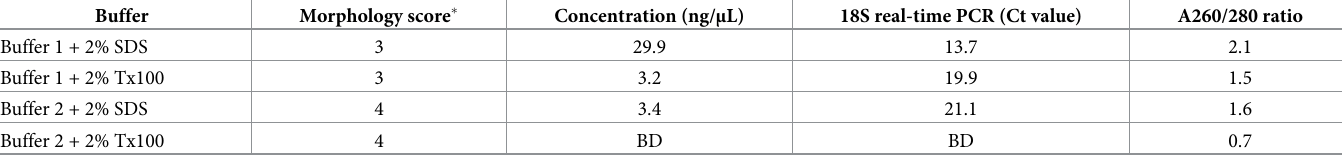
Table 1. Purity and yield of DNA extracts and morphology following lysis of approx. 0.1 g fruit flies (10–15) at 56˚C overnight in 1mL of either Buffer 1 or Buffer 2 containing Tx100 or SDS at 2%. BD = below detection. Ct = cycles above threshold (threshold set at 0.05).